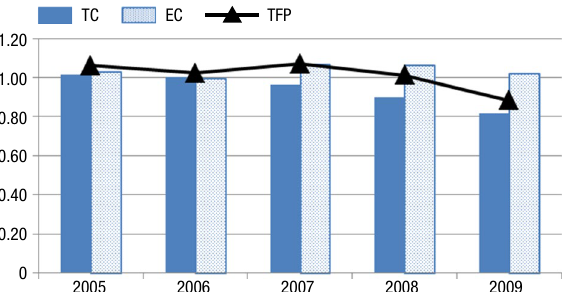
Fig. 4. The cumulative total factor productivity change in the livestock farms, 2004–2009